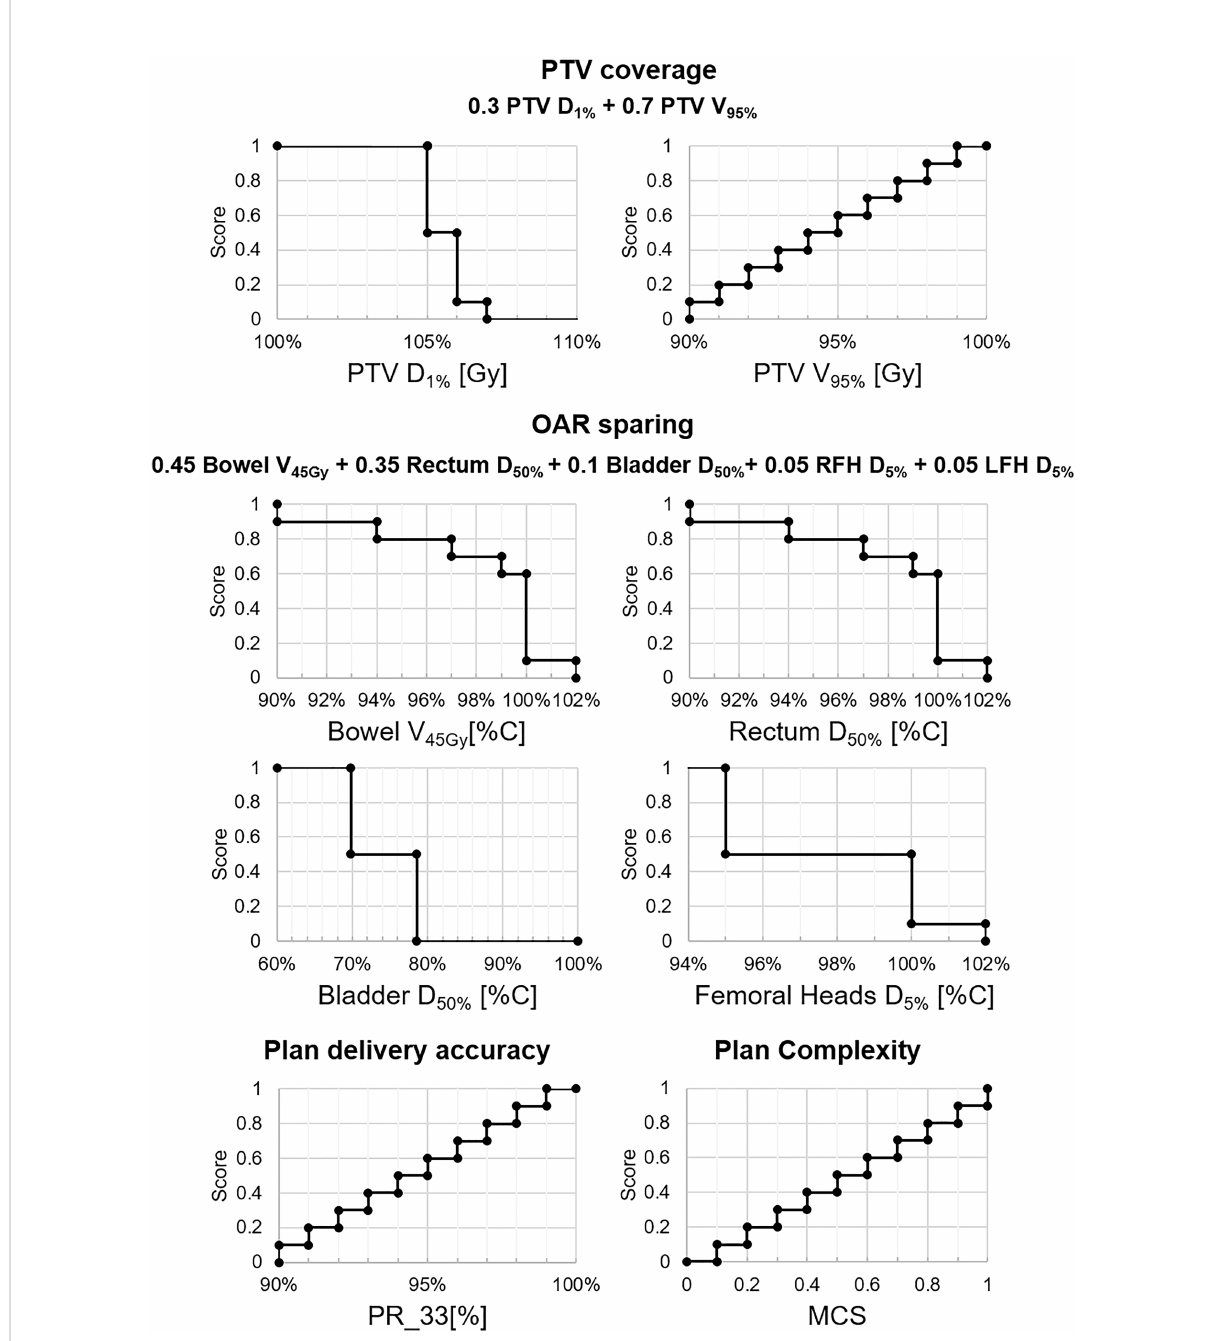
FIGURE 1 Scoring index components and de fi nition. The weighting of target coverage and OAR sparing index components are reported in the formulae. Abbreviations: PTV, planning target volume; OAR, organ-at-risk; D # , dose received by the # % of contoured volume; V # , volume receiving more than # Gy; RFH, right femoral head; LFH, left femoral head; PR_33, 3%/3 mm gamma passing ratio; MCS, modulation complexity